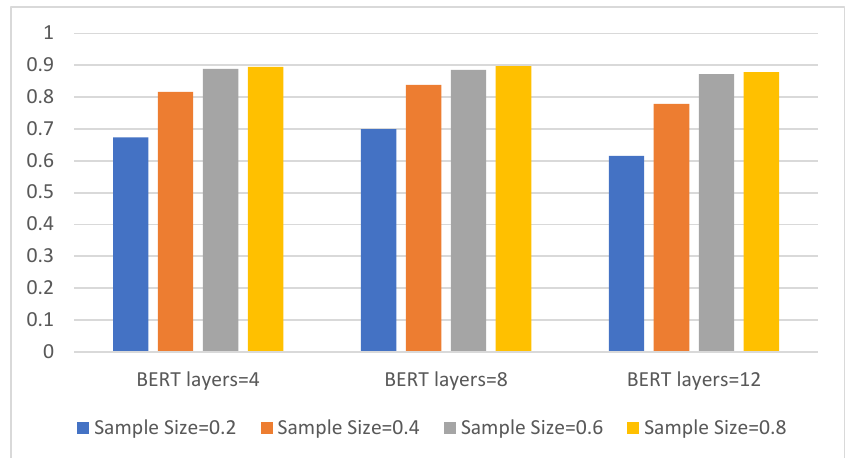
Figure 5. The three models with different BERT layers and eight-class accuracy on four sample sizes. The abscissa is the BERT model with three different layers, the ordinate is the eight-class accuracy, and the four colors represent four different sample sizes.